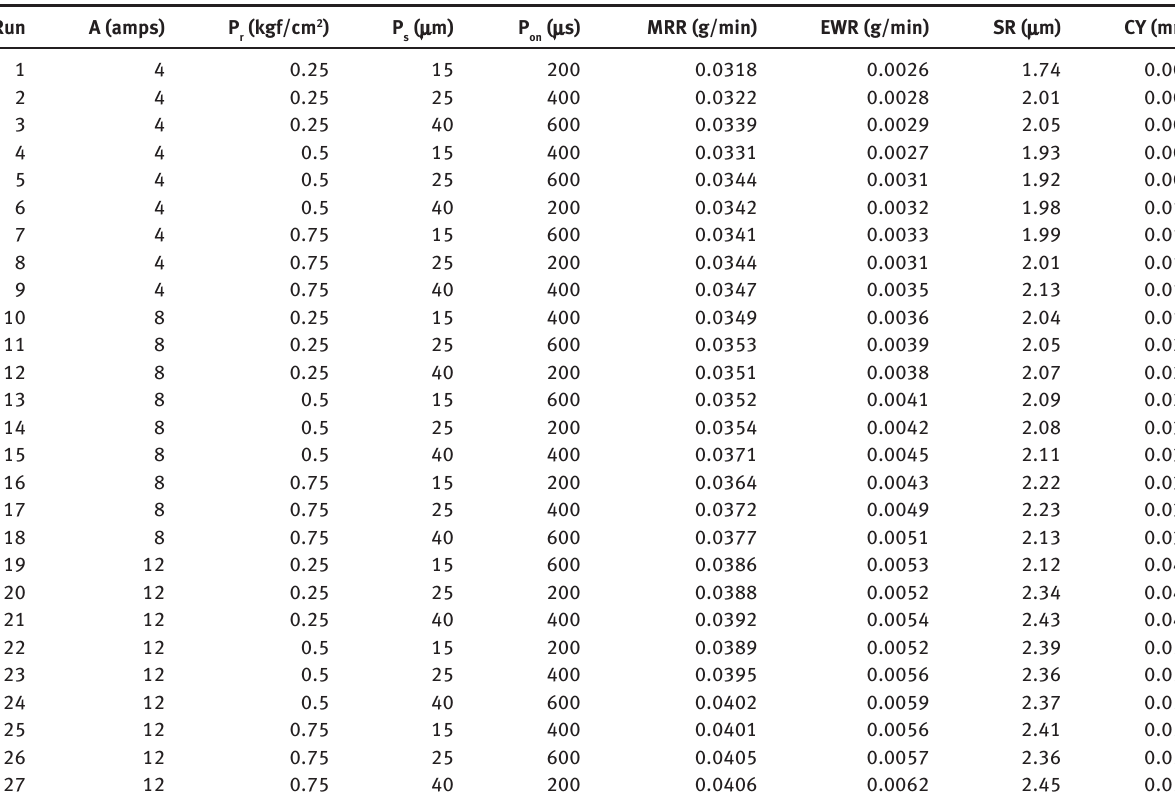
Table 3 Design matrix by